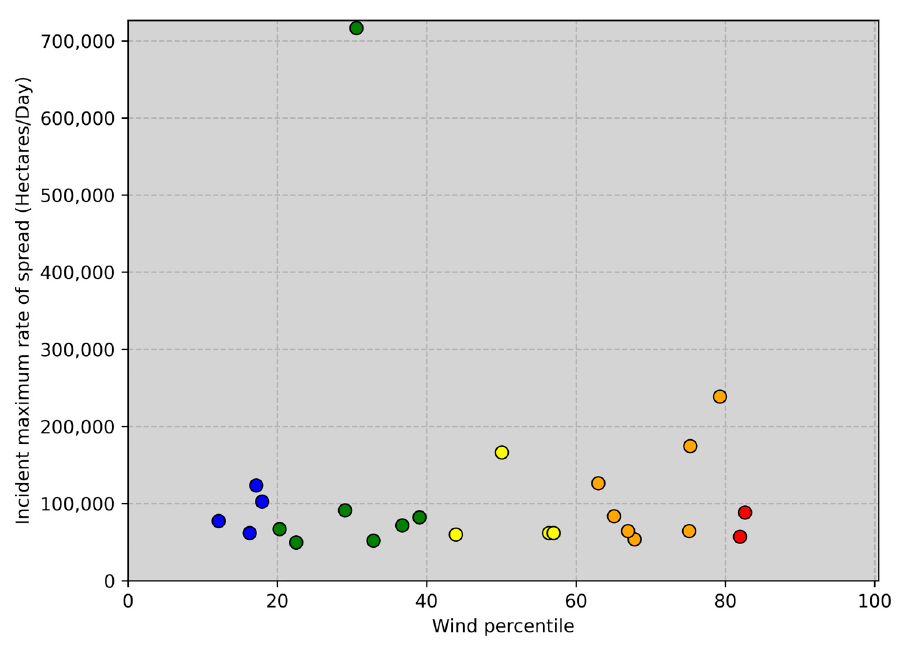
Figure 5. Wind speed percentiles for large incidents exceeding the statewide ROS breakpoint in OR, 1999–2014. Color scheme same as for Figure 3.